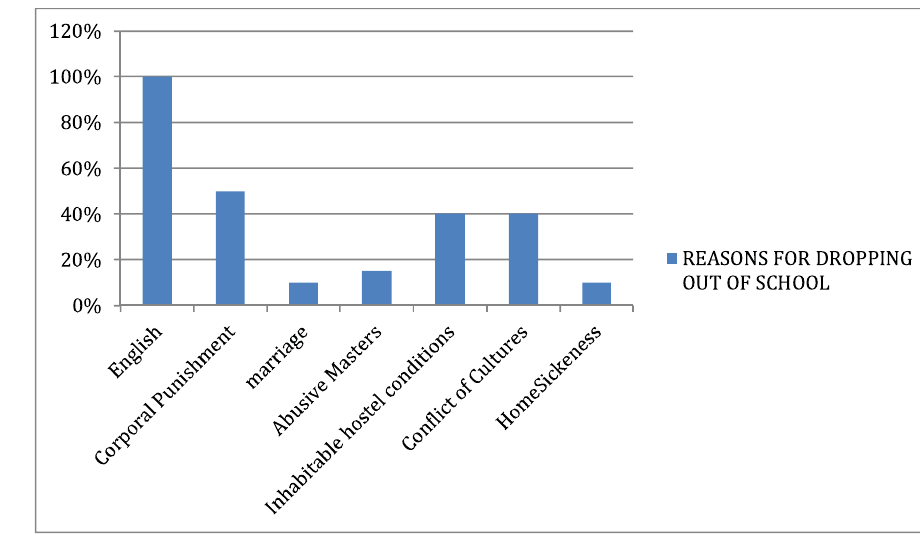
FIGURE 3 (Colour online) The reasons for dropping out of